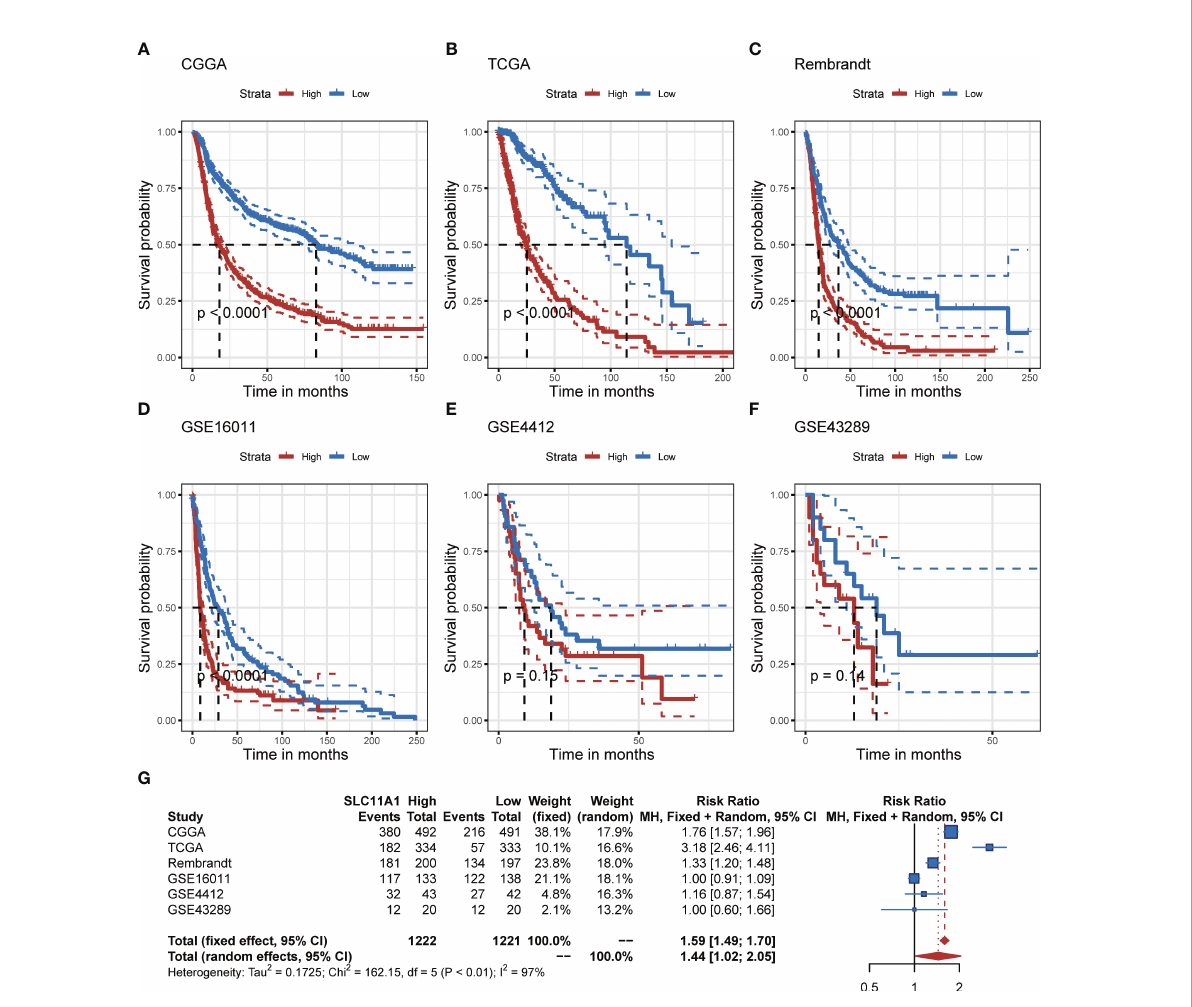
FIGURE 2 Elevation of SLC11A1 expression predicts poor prognosis in gliomas. Kaplan-Meier plots of SLC11A1 in six glioma datasets, 95% CI was also showed. Patients were divided into high and low expressed group by the medium expression level. (A) CGGA, (B) TCGA, (C)